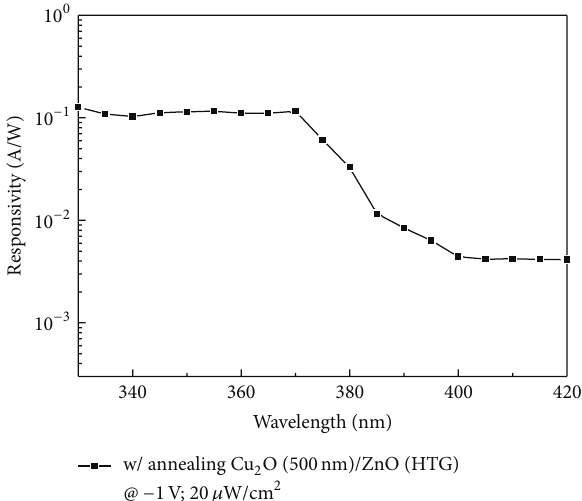
Figure 5: Spectral response of the p-Cu 2 O/ZnO (HTG) sample UV sensor measured at a reverse bias of 1V.